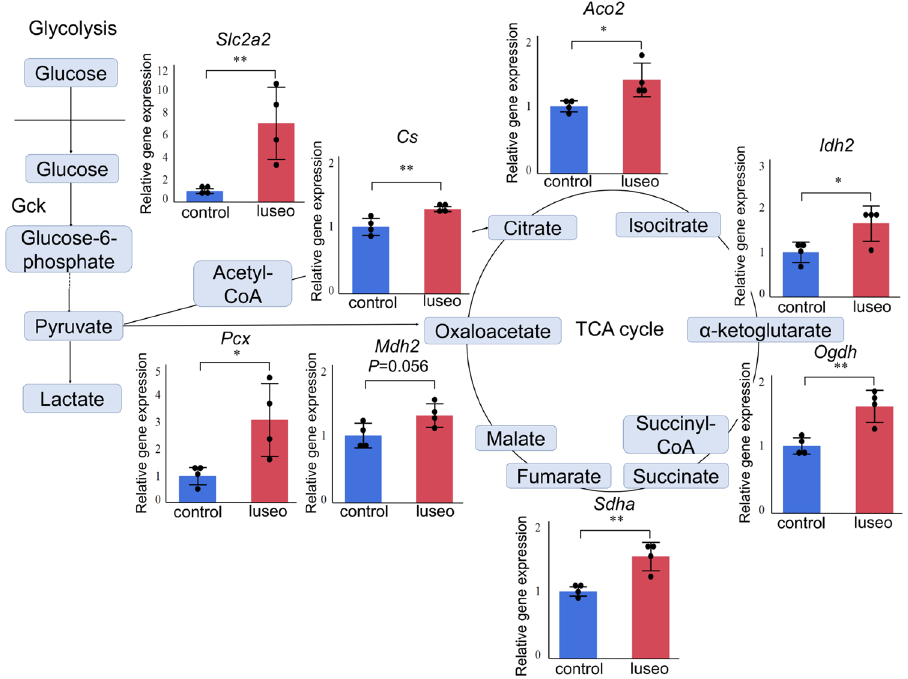
Figure 2. Effects of luseogliflozin on the expression of key genes in the pancreatic islets of 10-week-old db/db mice. Gene expression of Slc2a2, Pcx, Cs, Aco2, Idh2, Ogdh, Sdha, and Mdh2 in the control and luseo groups, measured using real-time PCR ( n = 4). The data were normalized to Gapdh expression. Values are mean ± SD. P values were determined using Student’s t test. * P < 0.05; ** P < 0.01. The figure was created by Microsoft PowerPoint® 2016 (https:// www. micro soft. com/ micro soft- 365/ power point). Slc2a2 , solute carrier family 2 member 2; Pcx , pyruvate carboxylase; Cs , citrate synthase; Aco2 , aconitase 2; Idh2 , isocitrate dehydrogenase 2; Ogdh , oxoglutarate dehydrogenase; Sdha , succinate dehydrogenase complex flavoprotein subunit a; Mdh2 , malate dehydrogenase 2, Gapdh , glyceraldehyde 3-phosphate